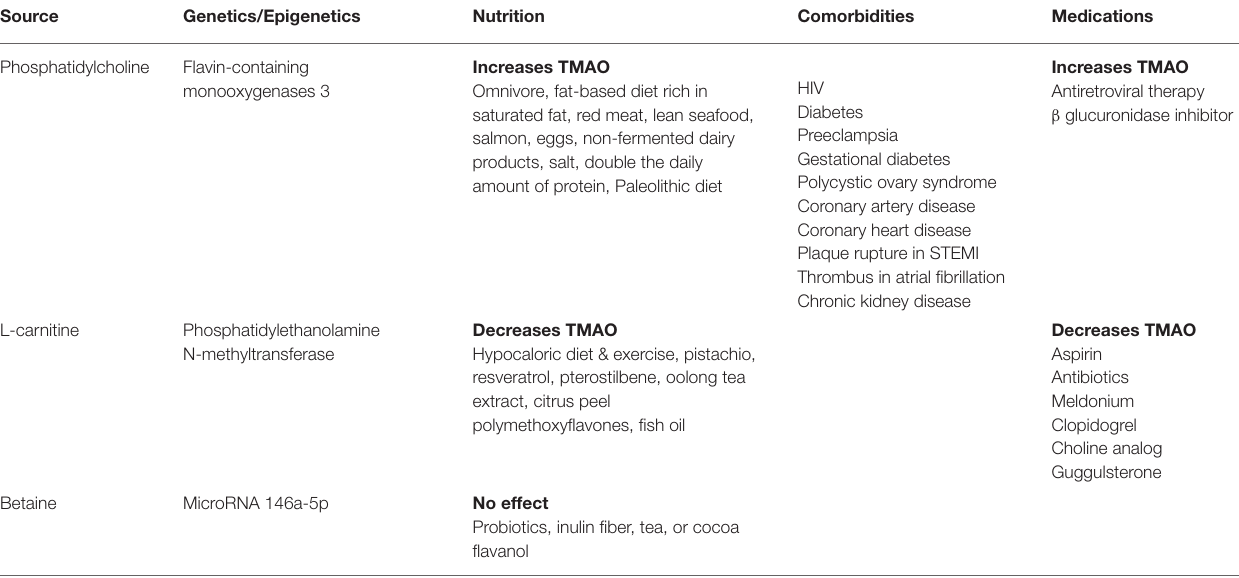
TABLE 3 | Impact of genetics, nutrition, medications on TMAO, and associated